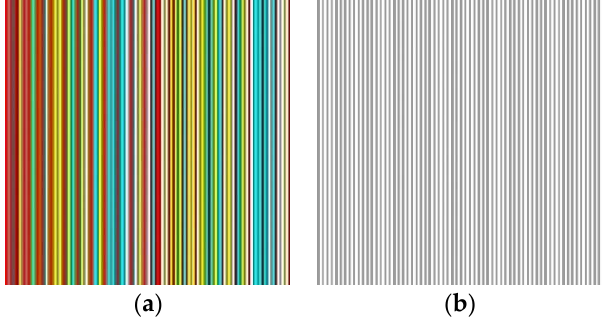
Figure 6. Color stripes pattern with an associated binary pattern: ( a ) color pattern; ( b ) binary pattern.